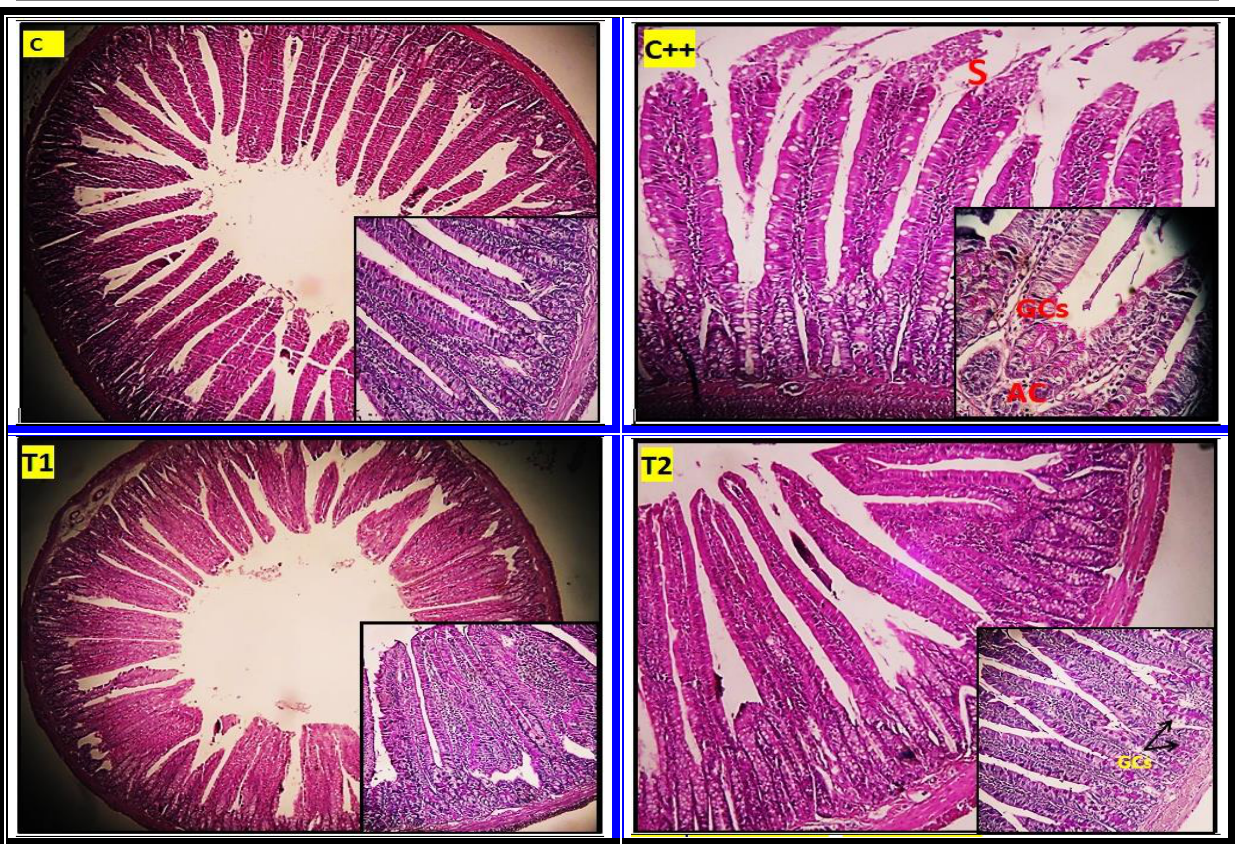
Figure 4A. Light microscopic image of duodenum sections represents the protective role of symbiotic against E. coli infection. N=4. Mean±SE. (GCs) secretory cells (goblet cells), (AC) Atrophy of crypt. (Pas and H&E). 100X , 200X, and 400X. C: control negative group C++: control positive group, T1; had fenugreek with enteritis, T2: had fenugreek and L. acidophilus with enteritis